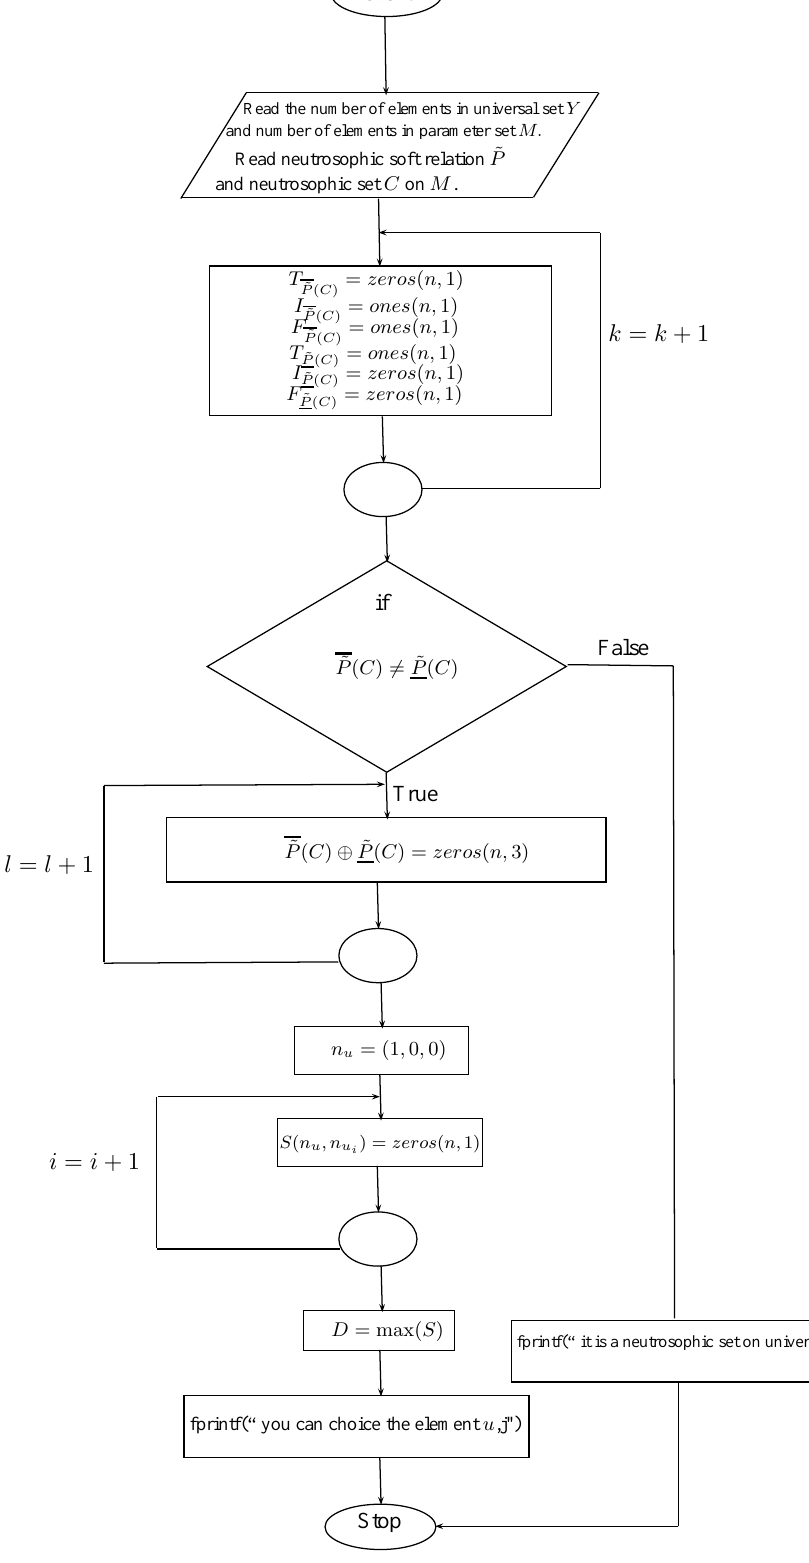
Figure 1: Flow chart for selection of most suitable objects Figure 1. Flow chart for selection of most suitable